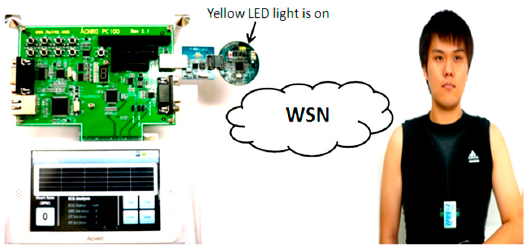
Figure 7. An illustration of the real time electrocardiogram (ECG) monitoring environment [13].